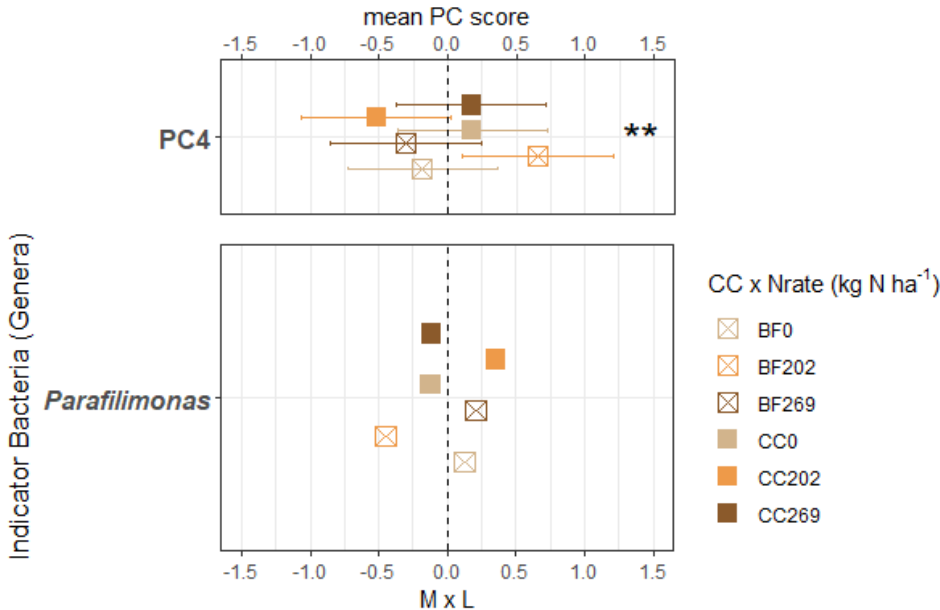
Figure 3. The top panel shows the estimated mean principal component (PC) scores of the bacterial PC4 for each level of N rate and cover cropping (CC × Nrate) treatment interactions with their standard errors as whiskers. The asterisks indicate the probability value of the treatment effect from analysis of variance (**: p < 0.05). The bottom panel shows the contribution of each bacterial indicator to PC4 multiplied by the mean PC scores of each level of N rate and cover cropping treatment interactions (M × L). The N rate treatment levels are: 0 kg N ha −1 (tan), 202 kg N ha −1 (orange), and 269 kg N ha −1 (brown). The cover cropping treatment levels are bare fallow (BF; crossed box) and cover crop mixture (CC; filled box).